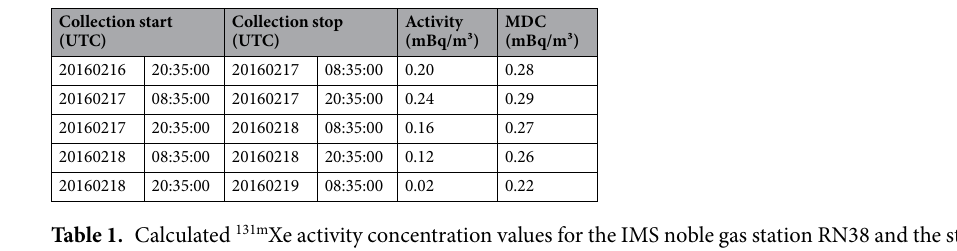
Table 1. Calculated 131m Xe activity concentration values for the IMS noble gas station RN38 and the station’s Minimum Detectable Concentration (MDC) from IMS